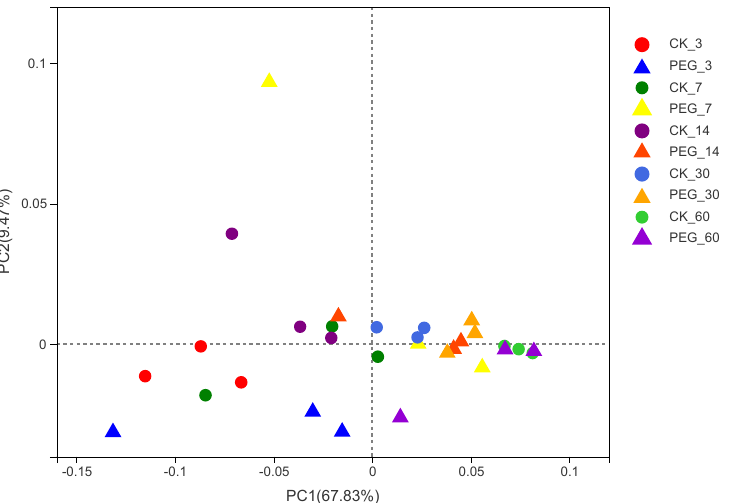
Figure 1. Principal − coordinate analysis (PCoA) plots based on weighted UniFrac distance for bacte- rial community of treatments × days (CK_3: on day 3 of ensiling without addition of polyethylene glycol (PEG); PEG_3: on day 3 of ensiling addition of PEG, same as others).